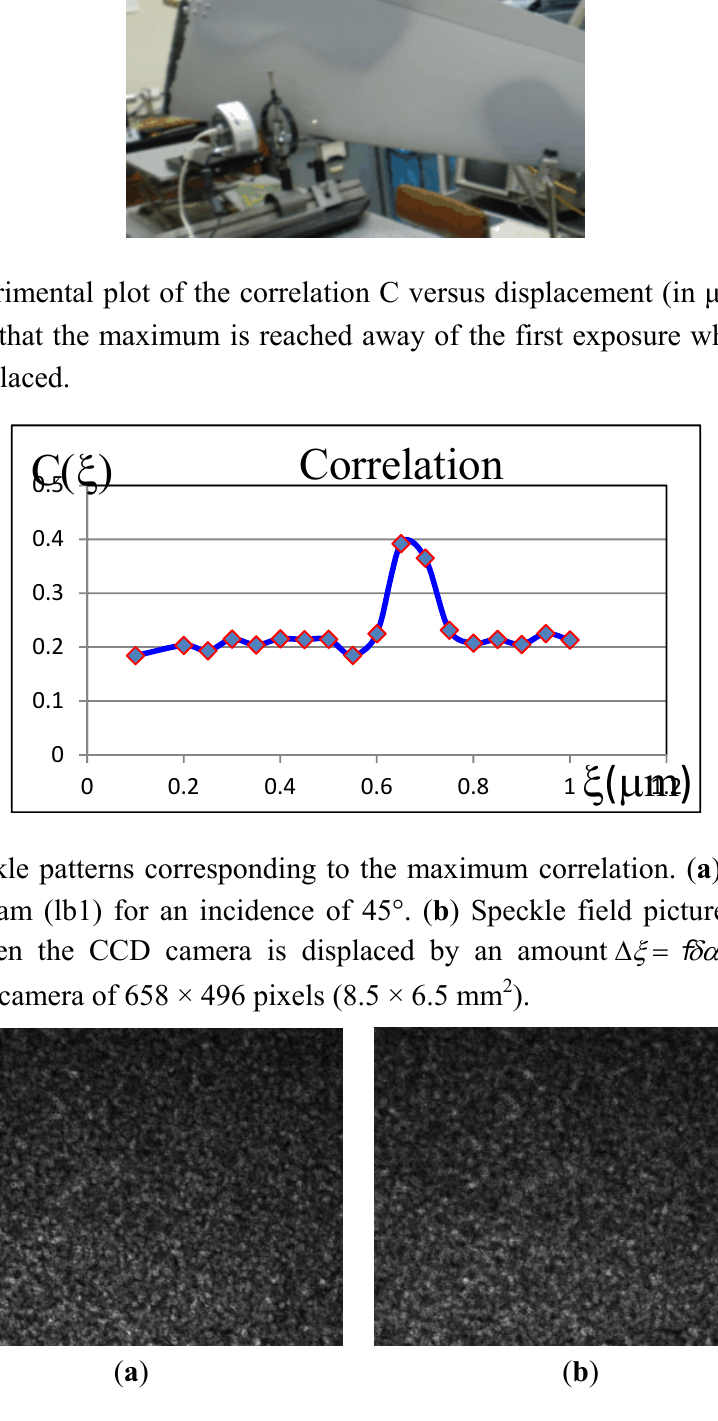
Figure 3. Experimental device. In this case the photograph shows a point located on the middle of the wing near the leading edge.